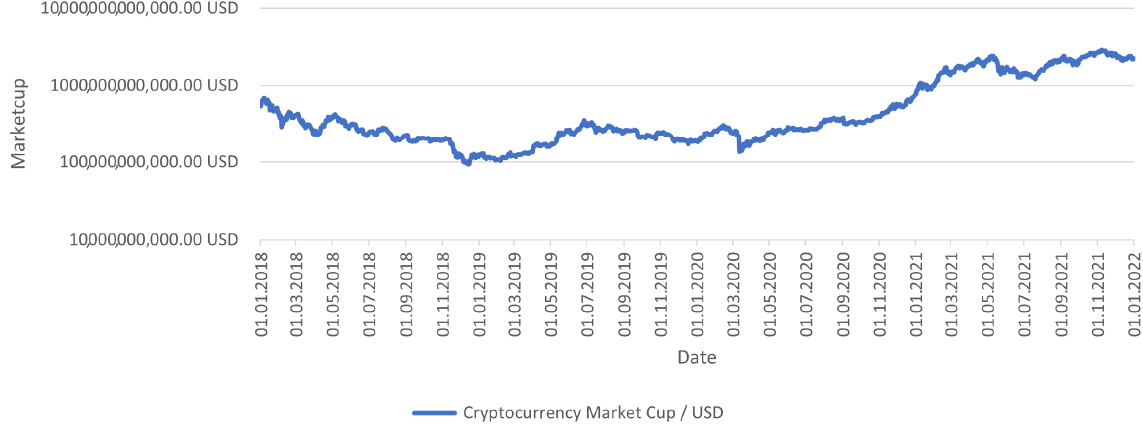
Figure 3. Cryptocurrency total market cup in the period under study.